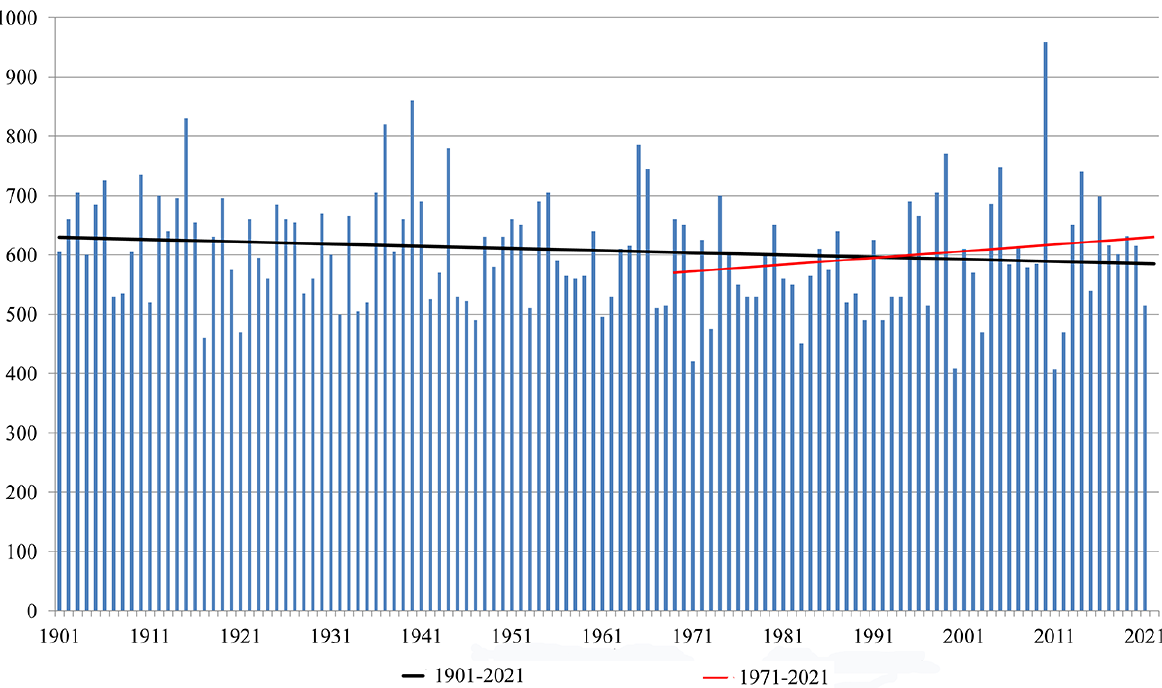
Figure 2. Annual rainfall (mm) in Hungary in 1901-2021 and its 120-year and 50-year trends (based on data of the Hungarian Meteorological